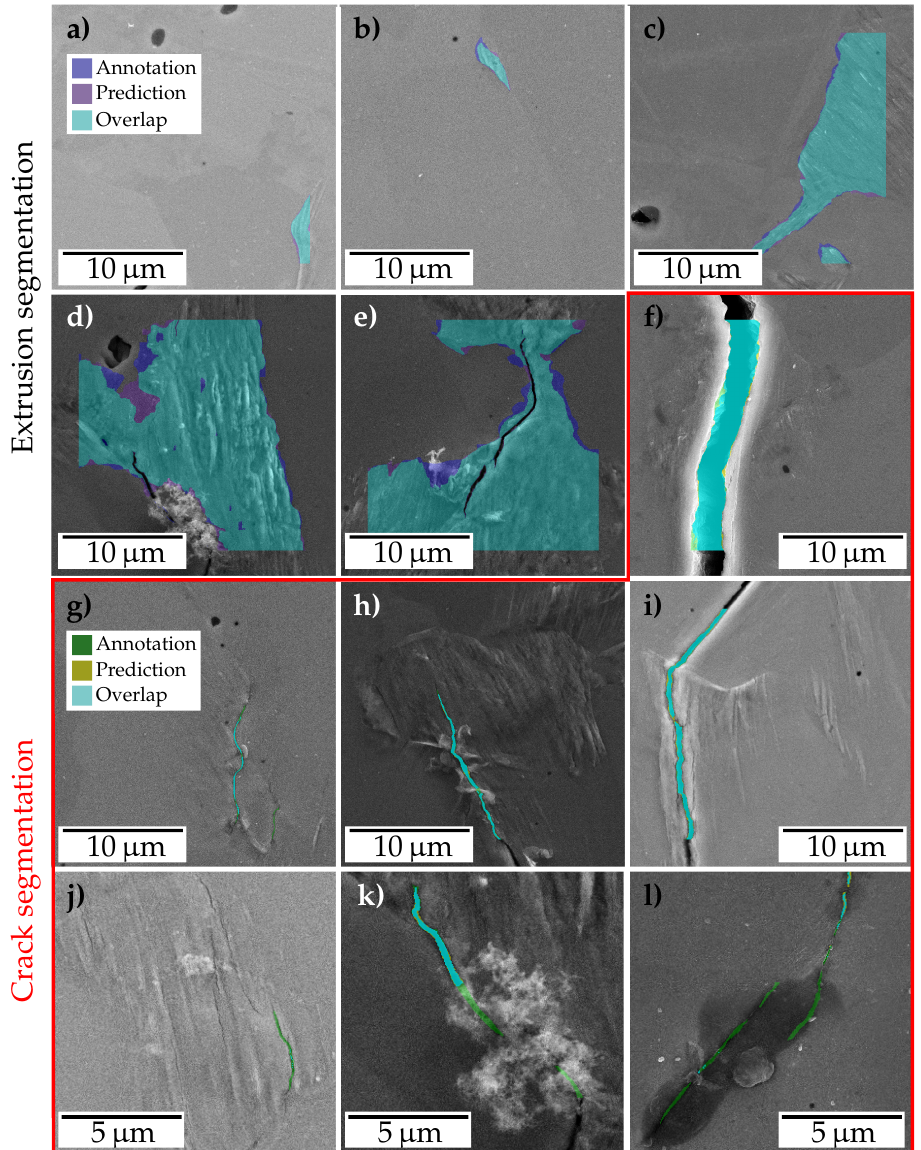
Figure 7. Examples for common cases of extrusion and crack segmentations. Note that the border regions of images ( a – i ) neither show annotations nor predictions since the latter is not provided by the network in these regions. Images ( j – l ) are an exception to this as they show a subset of